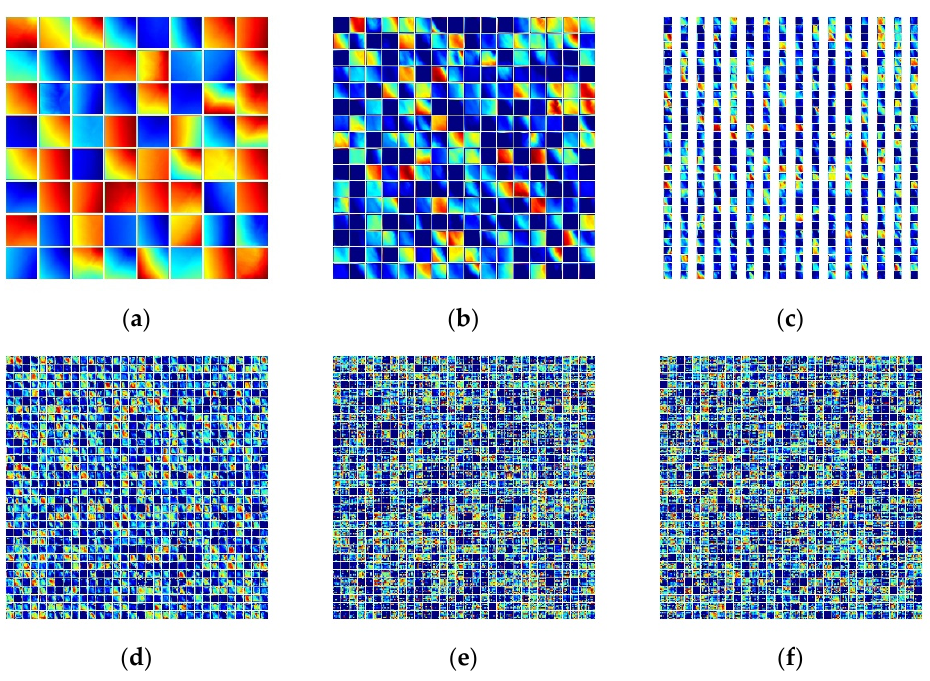
Figure 12. Feature map of BoTNet; ( a ) conv1, ( b ) layer1, ( c ) layer2, ( d ) layer3, ( e ) layer4_1 and ( f ) layer4_2.